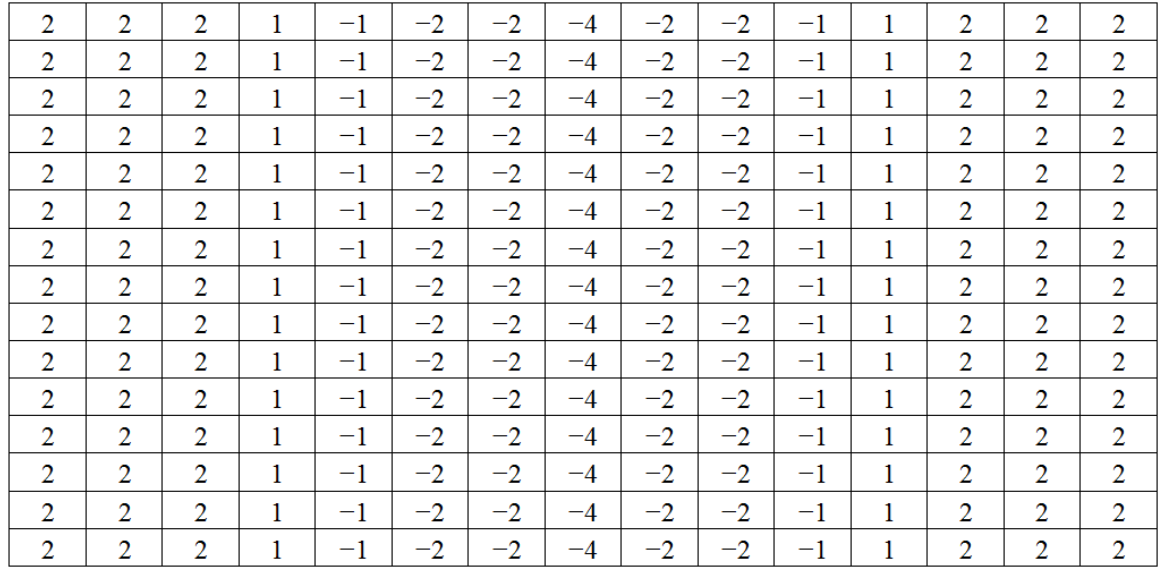
Figure 29. Modified filter with size of 15 ×